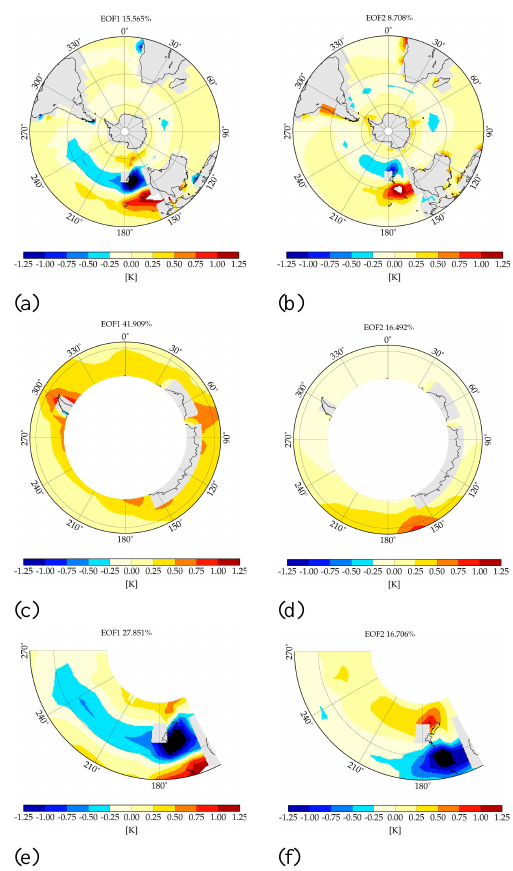
Fig. 10. (a) First EOF of SST 0 over the Southern Hemisphere. (b) The same as in (a) , but for the second EOF. (c) The same as in (a) , but over the ACC (60 ◦ –70 ◦ S). (d) The same as in (c) , but for the second EOF. (e) The same as in (a) , but for the Southern Pacific region (20 ◦ –60 ◦ S, 152 ◦ E–90 ◦ W). (f) The same as in (e) , but for the second